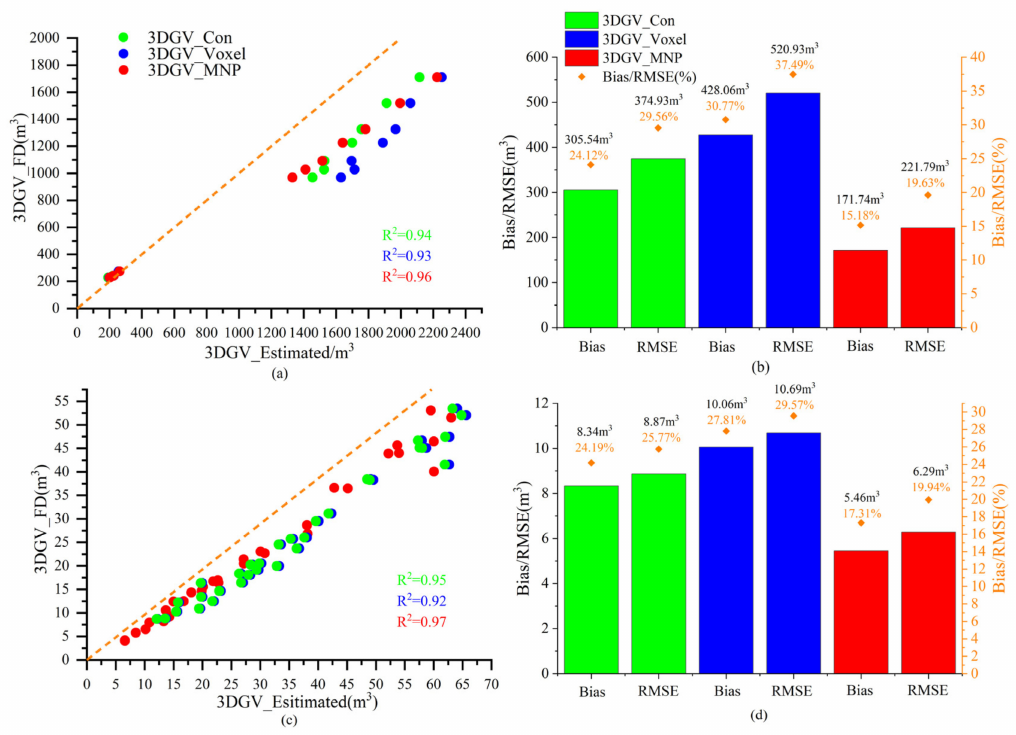
Figure 10. Accuracy assessment of 3DGV: ( a ) Scatter diagram of 3DGV_MNP, 3DGV_Con, and 3DGV_Voxel in plots; ( b ) bias, relative bias, RMSE, and relative RMSE of 3DGV_MNP, 3DGV_Con, and 3DGV_Voxel in plots; ( c ) scatter diagram of 3DGV_MNP, 3DGV_Con, and 3DGV_Voxel in individual trees; ( d ) bias, relative bias, RMSE, and relative RMSE of 3DGV_MNP, 3DGV_Con, and 3DGV_Voxel in individual